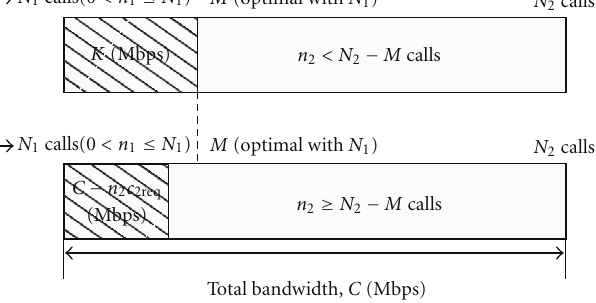
Figure 1: Resource (total bandwidth) reservation